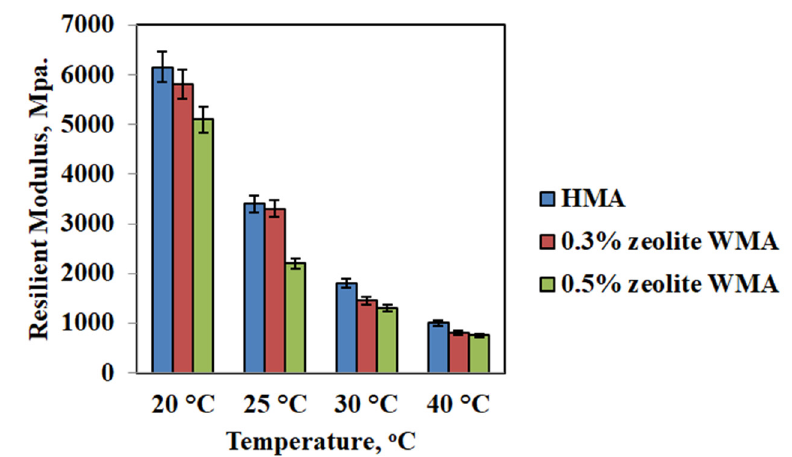
Figure 6. Resilient modulus result values.